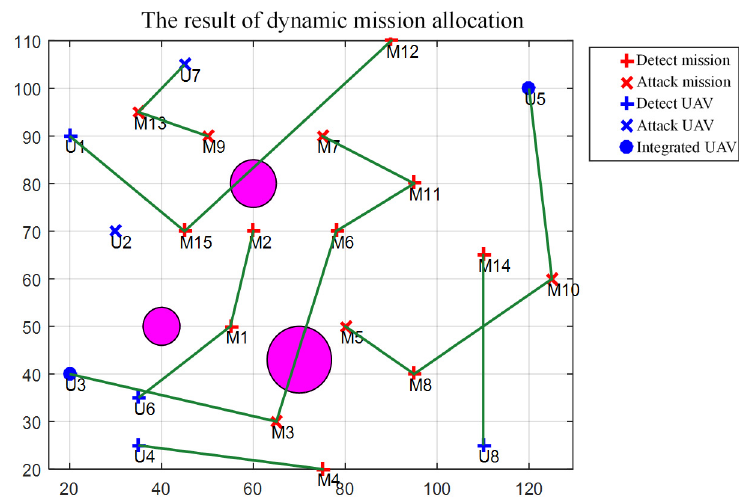
Figure 9. Task allocation results after new emergency tasks.